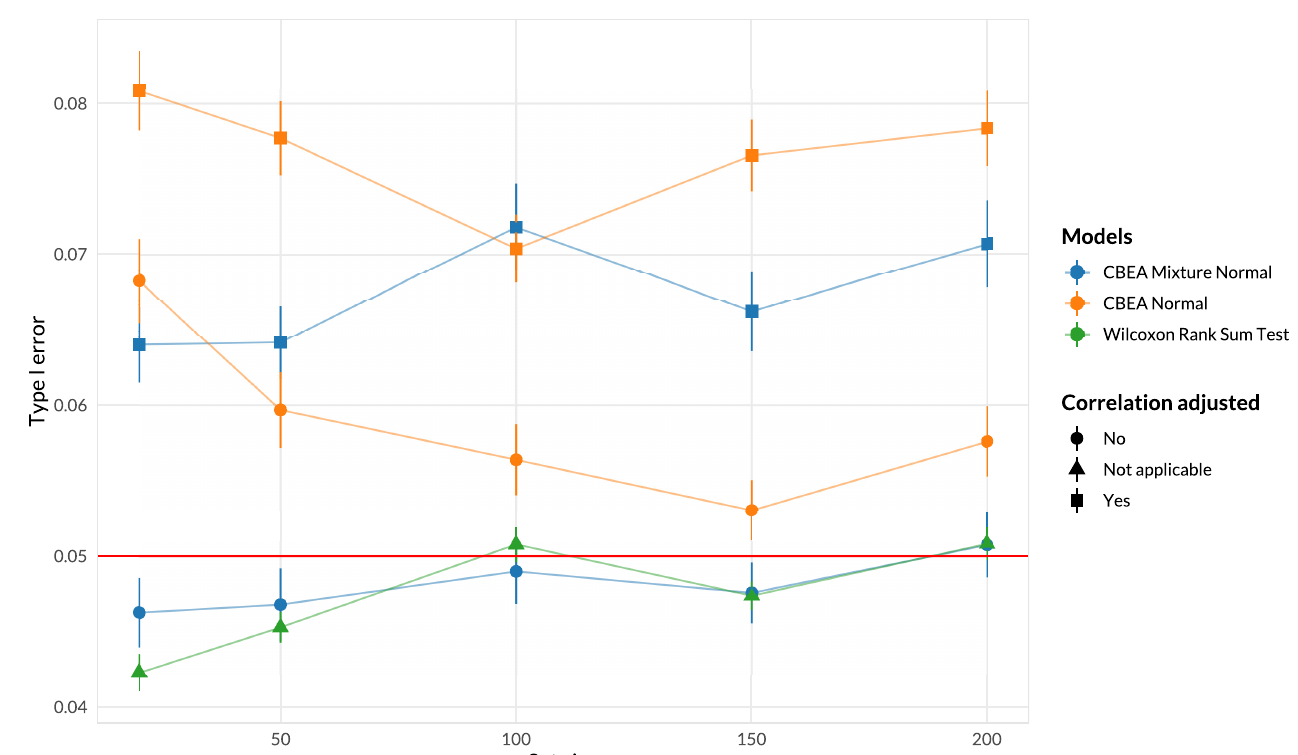
Fig 2. Random taxa set analyses for inference at the sample level of CBEA under different parametric assumptions compared against a Wilcoxon rank- sum test. Type I error ( y -axis) was evaluated by generating random sets of different sizes ( x -axis) (500 replications per size) and computing the fraction of samples in which the set was found to be significantly enriched at α = 0.05. Error bars represent the mean type I error ± sample standard error computed across 500 replications of the experiment. Only the unadjusted CBEA with the mixture normal distribution and the Wilcoxon rank sum test were able to control for type I error at 0.05. All approaches are invariant to set